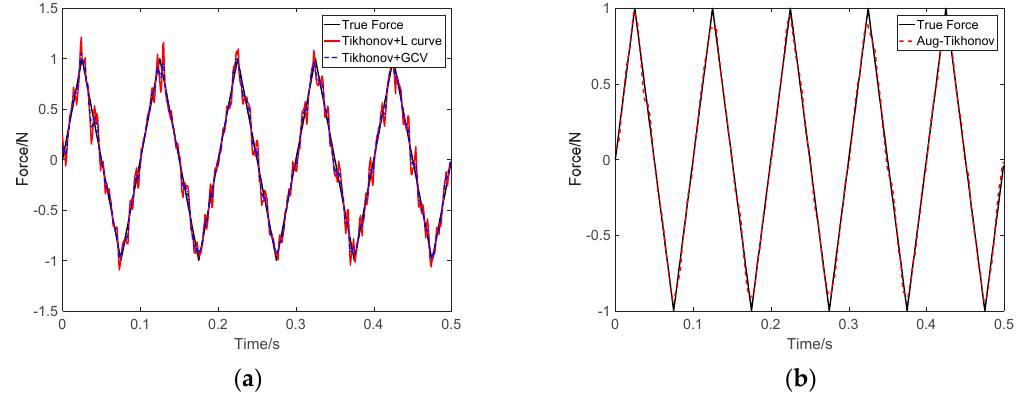
Figure 9. Identification result of triangle wave load at SNR 30 dB: ( a ) Tikhonov method; ( b ) the proposed method.